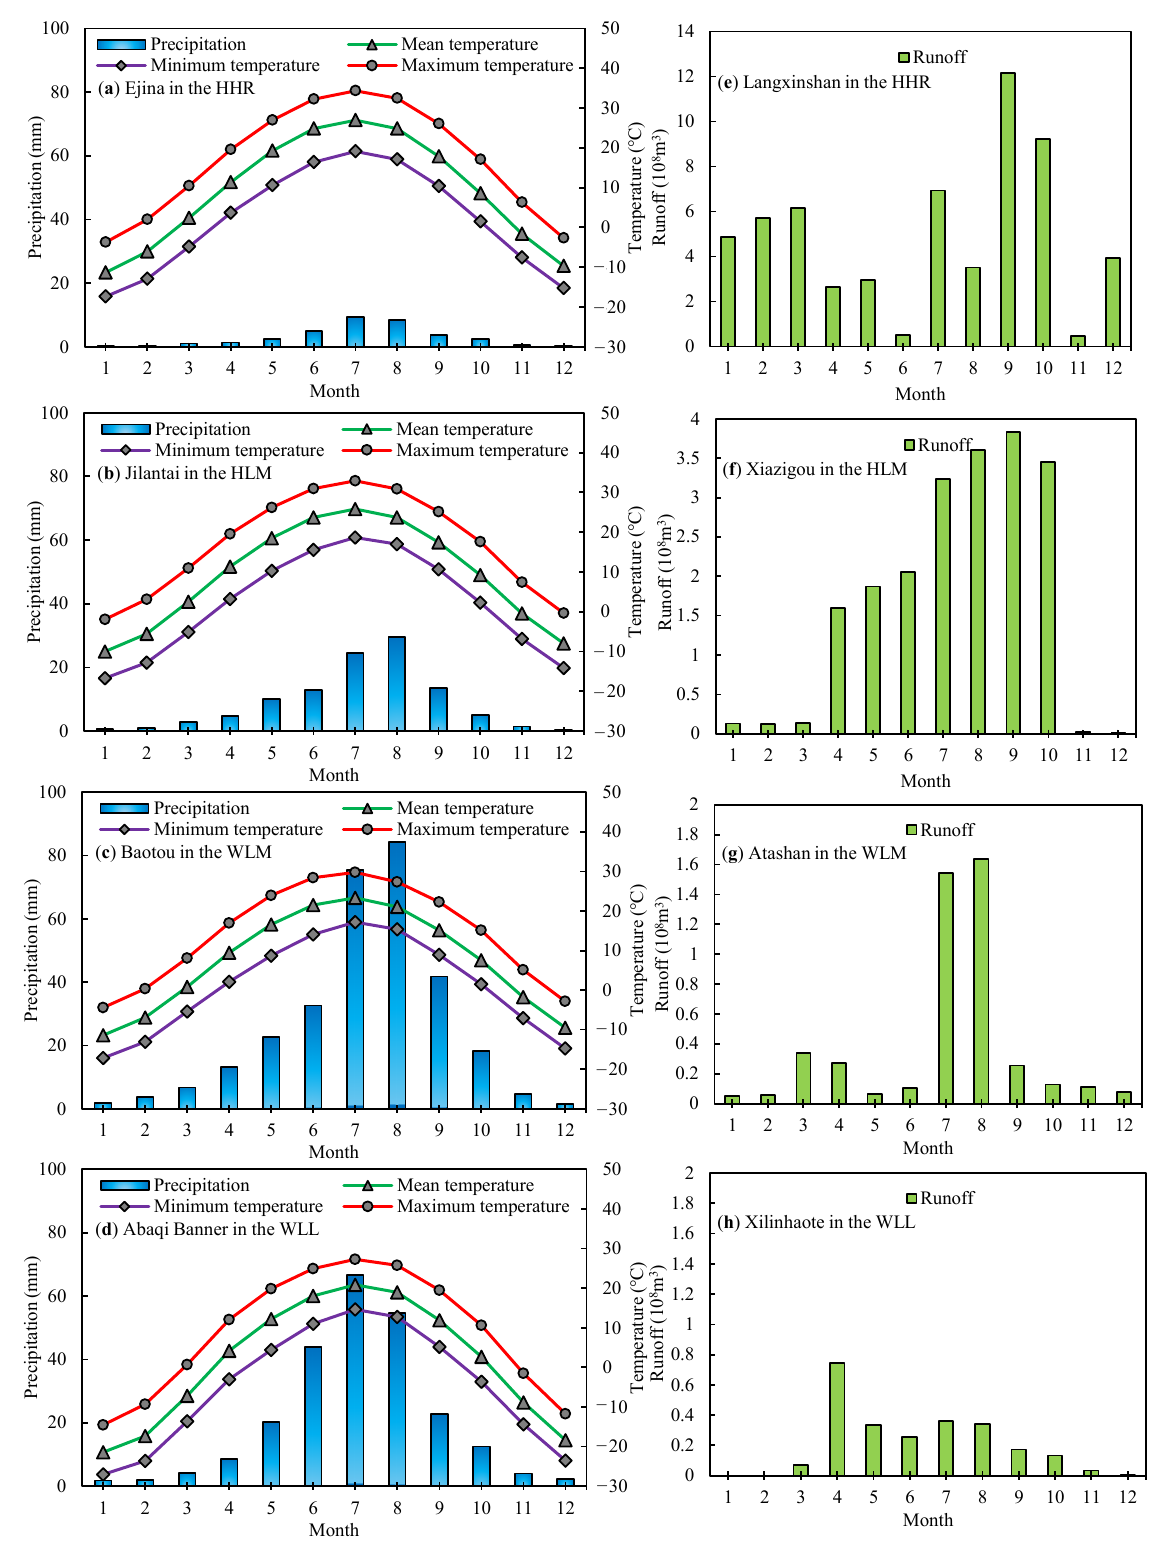
−−− Figure 2. Distribution of monthly hydroclimatic data for each sampling area in the study region from 1951 to 2016. ( a ) Ejina meteorological station; ( b ) Jilantai meteorological station; ( c ) Baotou meteorological station; ( d ) Abaga Banner meteorological station; ( e ) Langxinshan hydrological station; ( f ) Xiazigou hydrological station; ( g ) Atashan hydrological station; ( h ) Xilinhaote hydrological station.